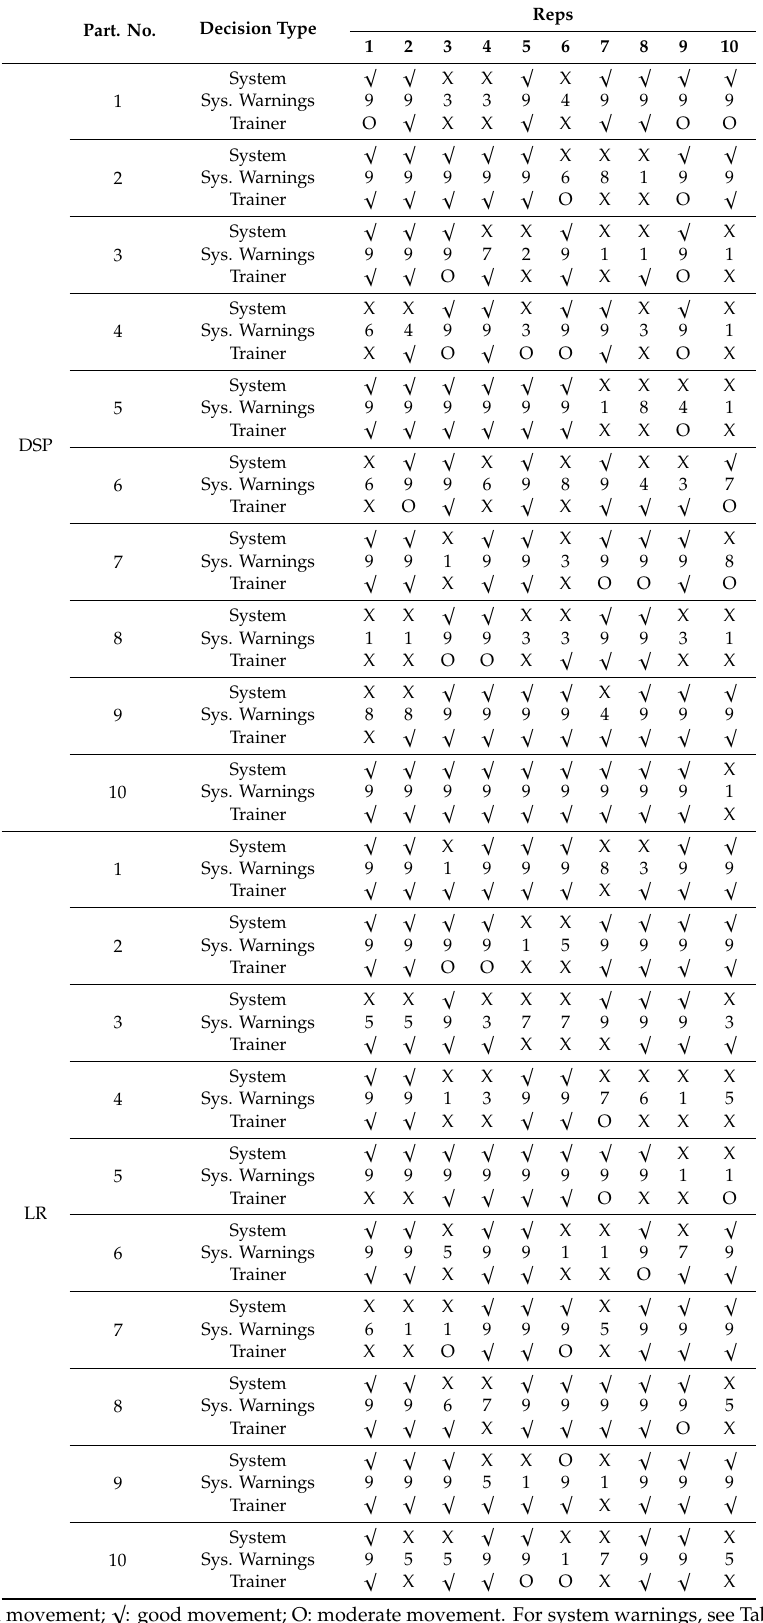
Table 7. Comparison of the System and Trainer Decisions. Part.